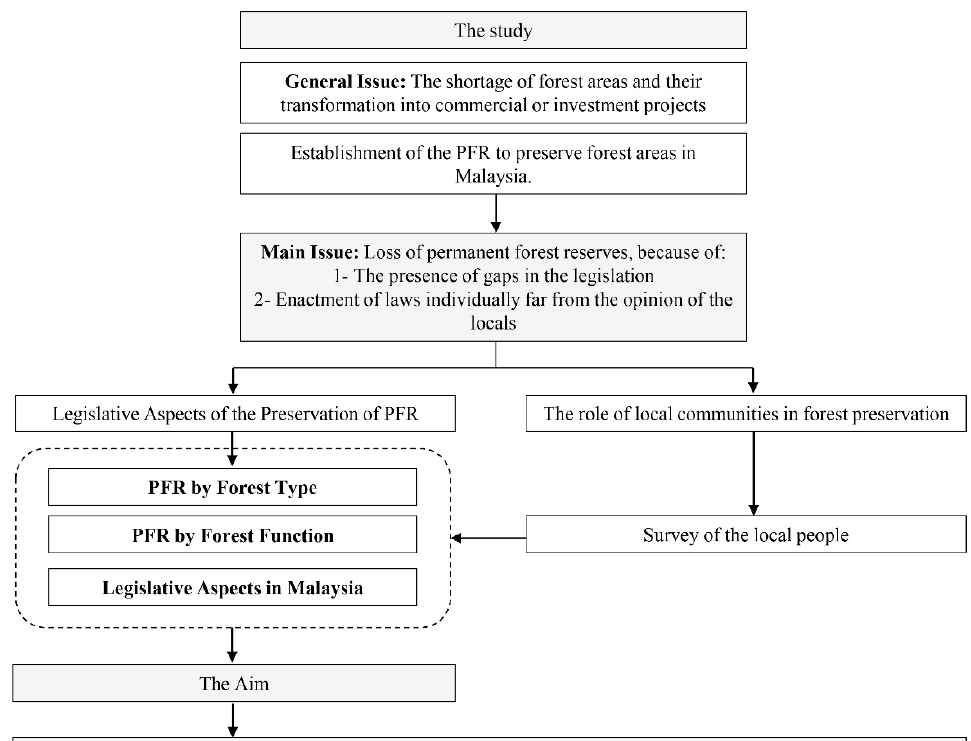
Figure 1. The framework of this study.